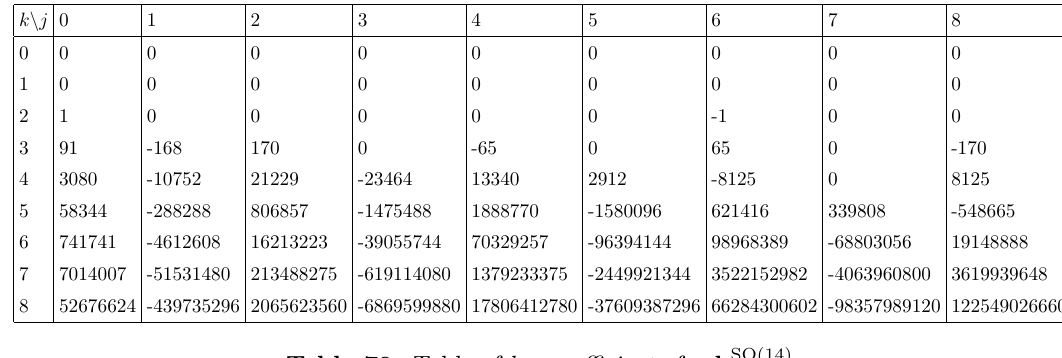
Table 79. Table of b jk coe(cid:14)cients for h SO(14)